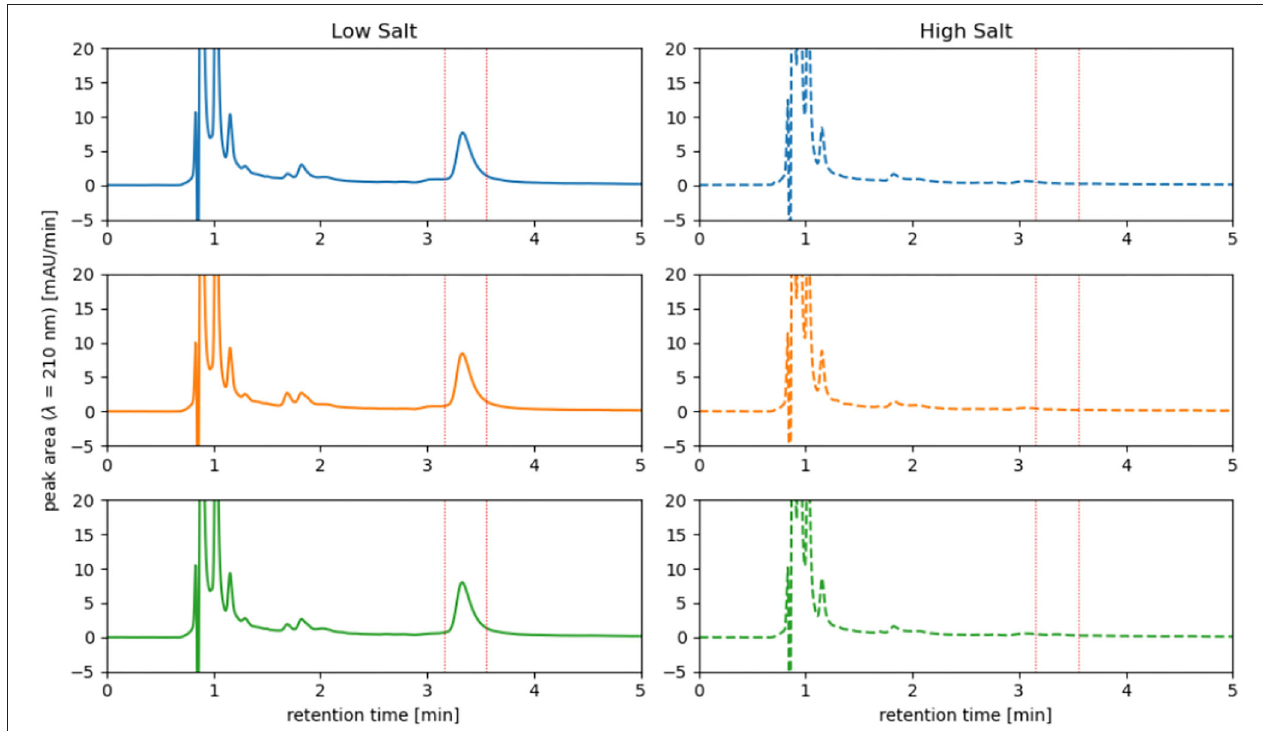
FIGURE 5 | HPLC analysis of PHB accumulated in H. elongata wildtype in low salt condition (0.17 M NaCl) vs. high salt condition (2 M NaCl). At a retention time of approximately 3.25 min a distinct peak is visible for all three replicates grown at low salt while at high salt no peak can be observed. Analysis was performed by conversion of PHB into crotonic acid and detection at 210